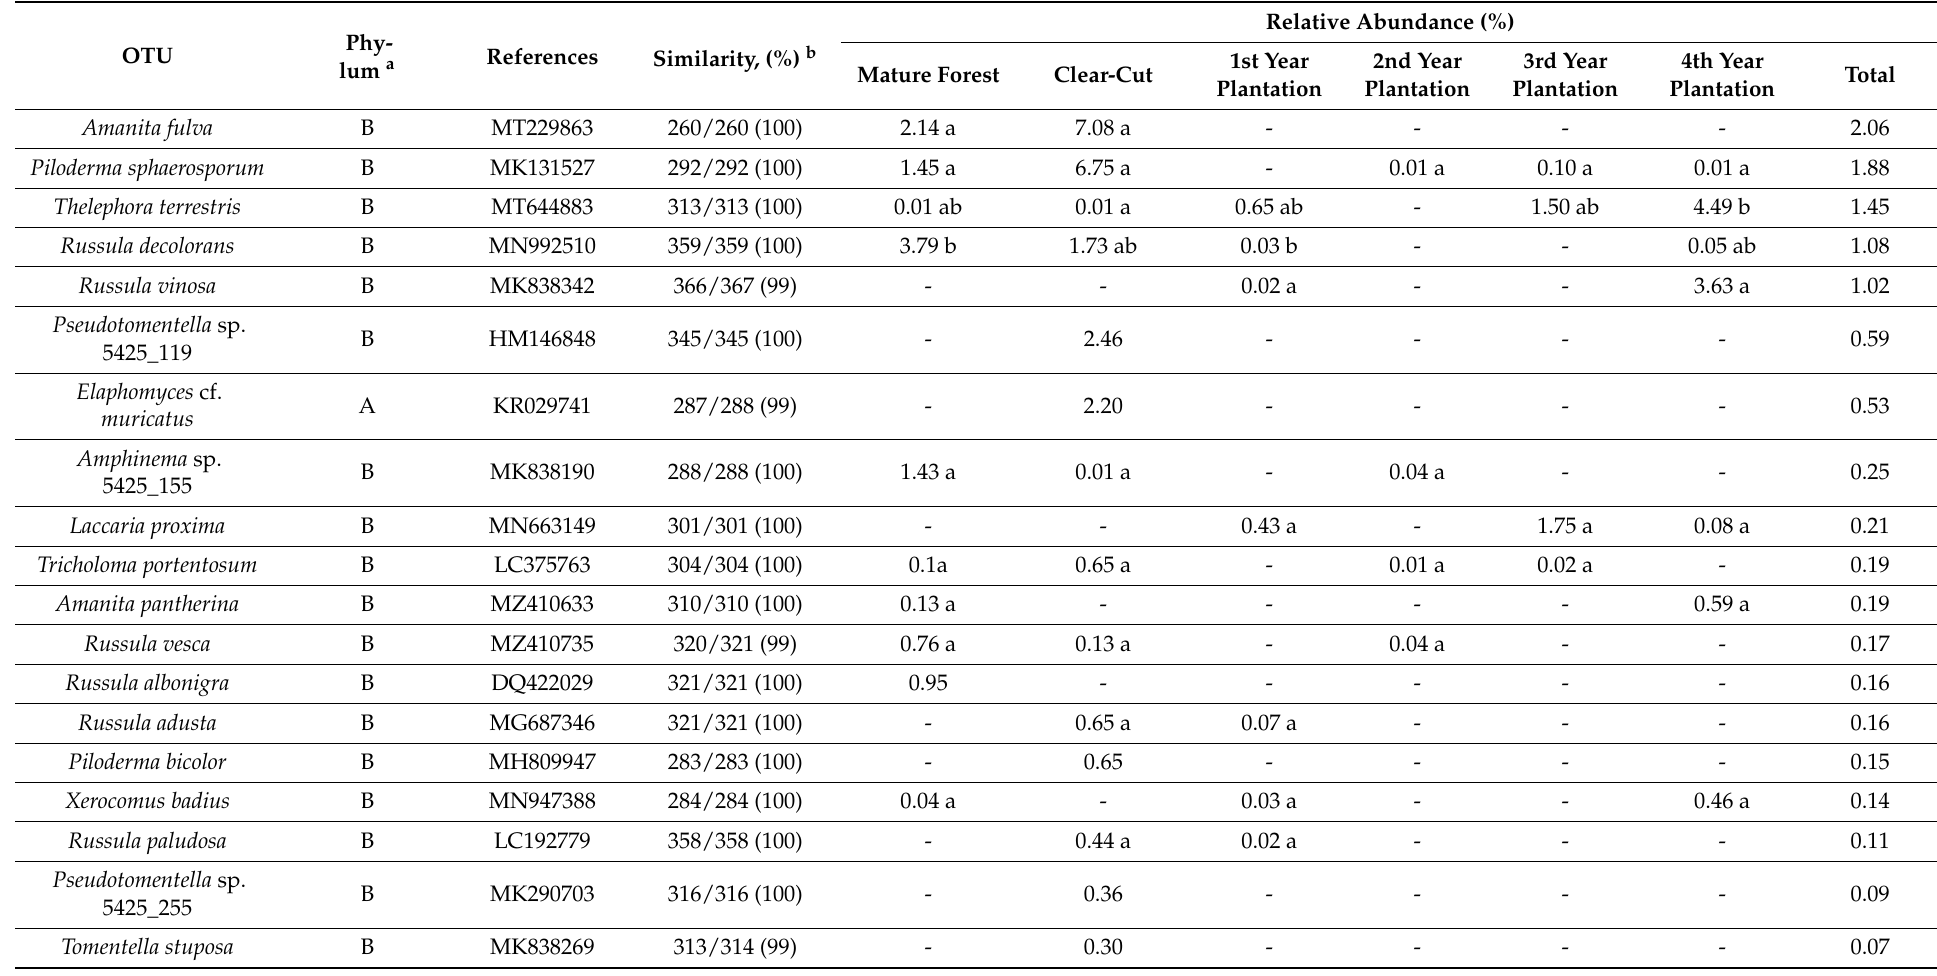
Table 5. Relative abundance and similarity of the 30 most common ectomycorrhizal (ECM) fungal OTUs in the soil samples from the Pinus sylvestris L. sites, representing mature forest stands, clear-cuts, and reforested 1st–4th year plantations; the data from three study sites (A, L, and V) were combined. The